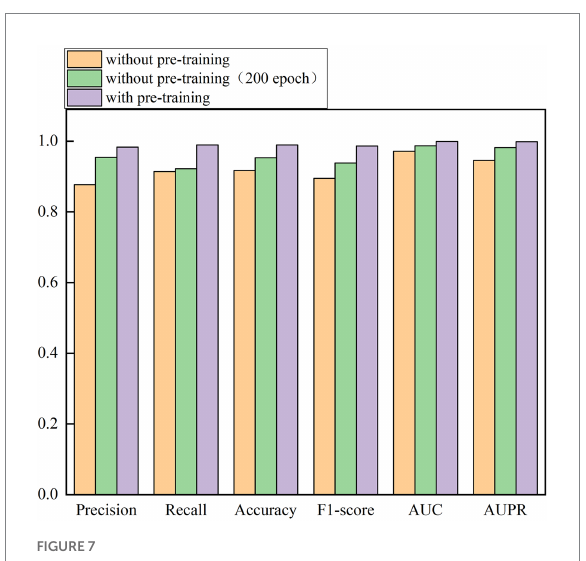
FIGURE 7 The affect of transfer learning on the performance.